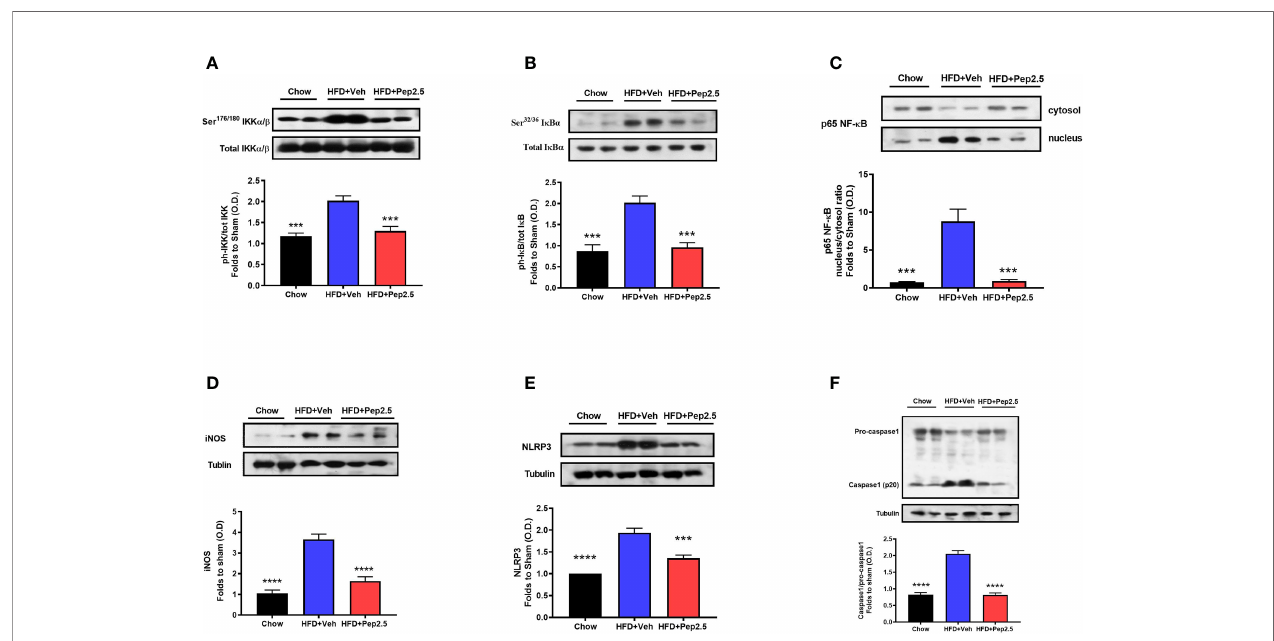
FIGURE 6 | Peptide 19-2.5 reduces liver in fl ammation via the inhibition of NF- k B signaling pathway and the activation of NLRP3 in fl ammasome in the liver of HFD- fed mice. Liver samples were collected at the end of the experiment and the NF- k B signaling pathway, as well as the activation of the NLRP3 in fl ammasome were assessed. Densitometry analysis of the bands is expressed as relative optical density (O.D.) of the (A) phosphorylation of IKK a / b at Ser 178/180 corrected for the corresponding total IKK a / b content and normalized using the related chow band; (B) phosphorylation of I ĸ B a at Ser 32/36 corrected for the corresponding total I ĸ B a content and normalized using the related chow band; (C) NF- k B p65 subunit levels in both, cytosolic and nuclear fractions expressed as a nucleus/cytosol ratio normalized using the related chow bands; (D) inducible nitric oxide synthase (iNOS) expression corrected for the corresponding tubulin band. (E) NLRP3 activation, corrected against tubulin and normalized using the related chow bands and the (F) proteolytic cleavage of pro-caspase-1 to activated caspase-1 and normalized using the related chow band. Data were analyzed by one-way ANOVA, with Bonferroni ’ s post-hoc test. Data are expressed as mean ± SEM; chow (n = 5), HFD +Veh (n = 6), HFD+Pep2.5 (n = 6). ***P< 0.001, and ****P < 0.0001 vs.